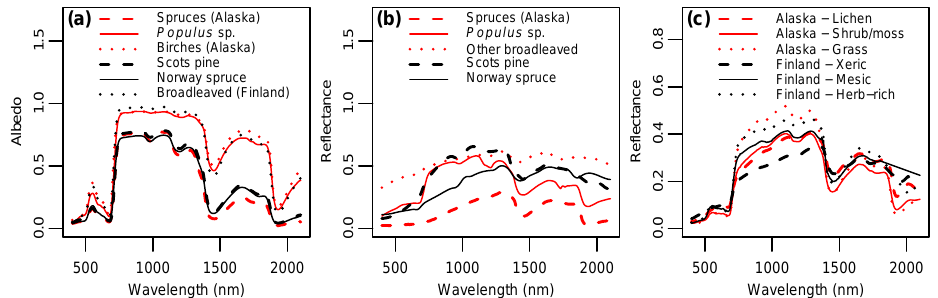
Figure 3. Spectra of vegetation elements used in the simulations: (a) leaves/shoots, (b) bark, and (c) forest floor. The values for leaf and shoot are single scattering albedos (reflectance + transmittance), and the values for bark and forest floor are reflectance